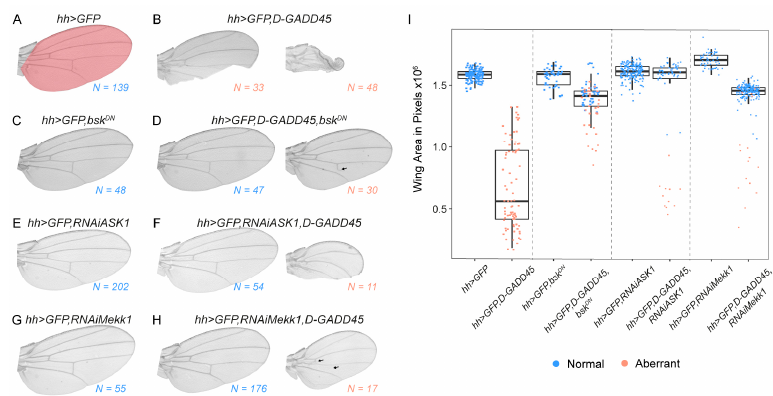
Figure 2. Sustained expression of D-GADD45 results in smaller and aberrant wings. ( A – H ) Adult wings showing the predominant phenotypes observed after sustained expression of each construct in the posterior ( hedgehog, hh ) compartment. Number of wings analyzed is indicated for each condition. Colored region in ( A ) represents the area selected to calculate wing size. ( I ) Box plot showing the average area of adult wings obtained after the expression of each combination of constructs in the posterior ( hedgehog, hh) compartment. Each dot represents one wing; wild-type pattern (blue) and aberrant pattern (orange).